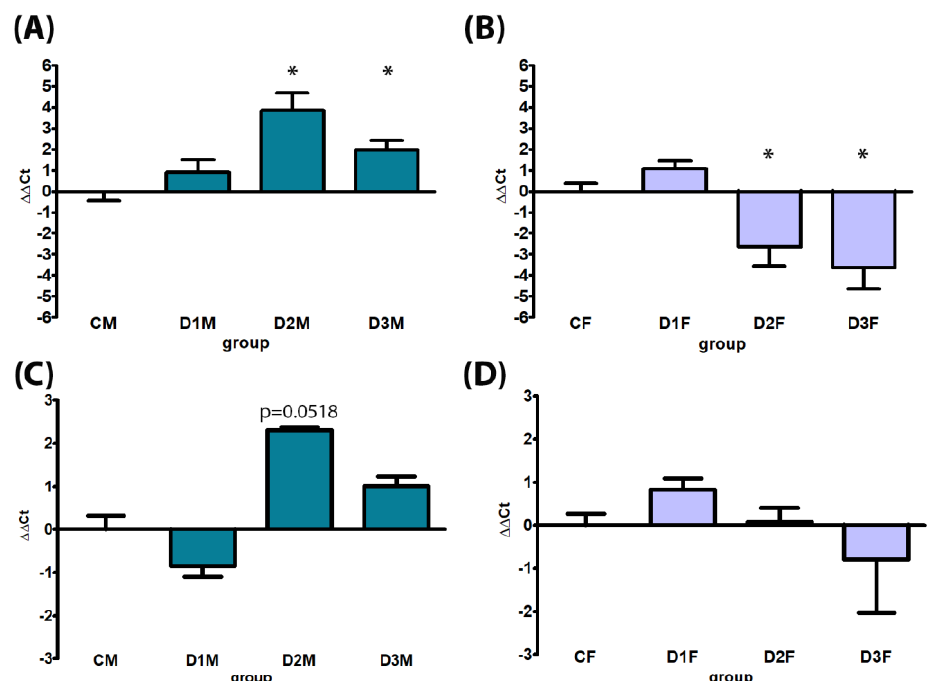
Figure 10. Comparison between gene expression analysis of sex (female)-specific genes CYP2C12 (Panels ( A , B ) and CYP2C6 (Panels ( C , D ) by real-time PCR in male and female rat livers. Male rats, panels ( A , C ), subcutaneously treated with different doses of estradiol valerate plus cyproterone acetate five times a week, for 2 weeks: C 0—sesame oil, D1M 0.09 + 0.33, D2M 0.09 + 0.93, and D3M 0.18 + 0.33 mg. Female rats, panels ( B , D ), subcutaneously treated with different doses of testosterone enanthate two times a week, for 2 weeks: CF: 0—sesame oil, D1F 0.45, D2F 0.95, and D3F 2.05 mg. Data are presented as mean ∆∆Ct values ± standard deviation, with control samples as calibrators and GAPDH as the reference gene. Statistical significance: * p < 0.05 Mann–Whitney